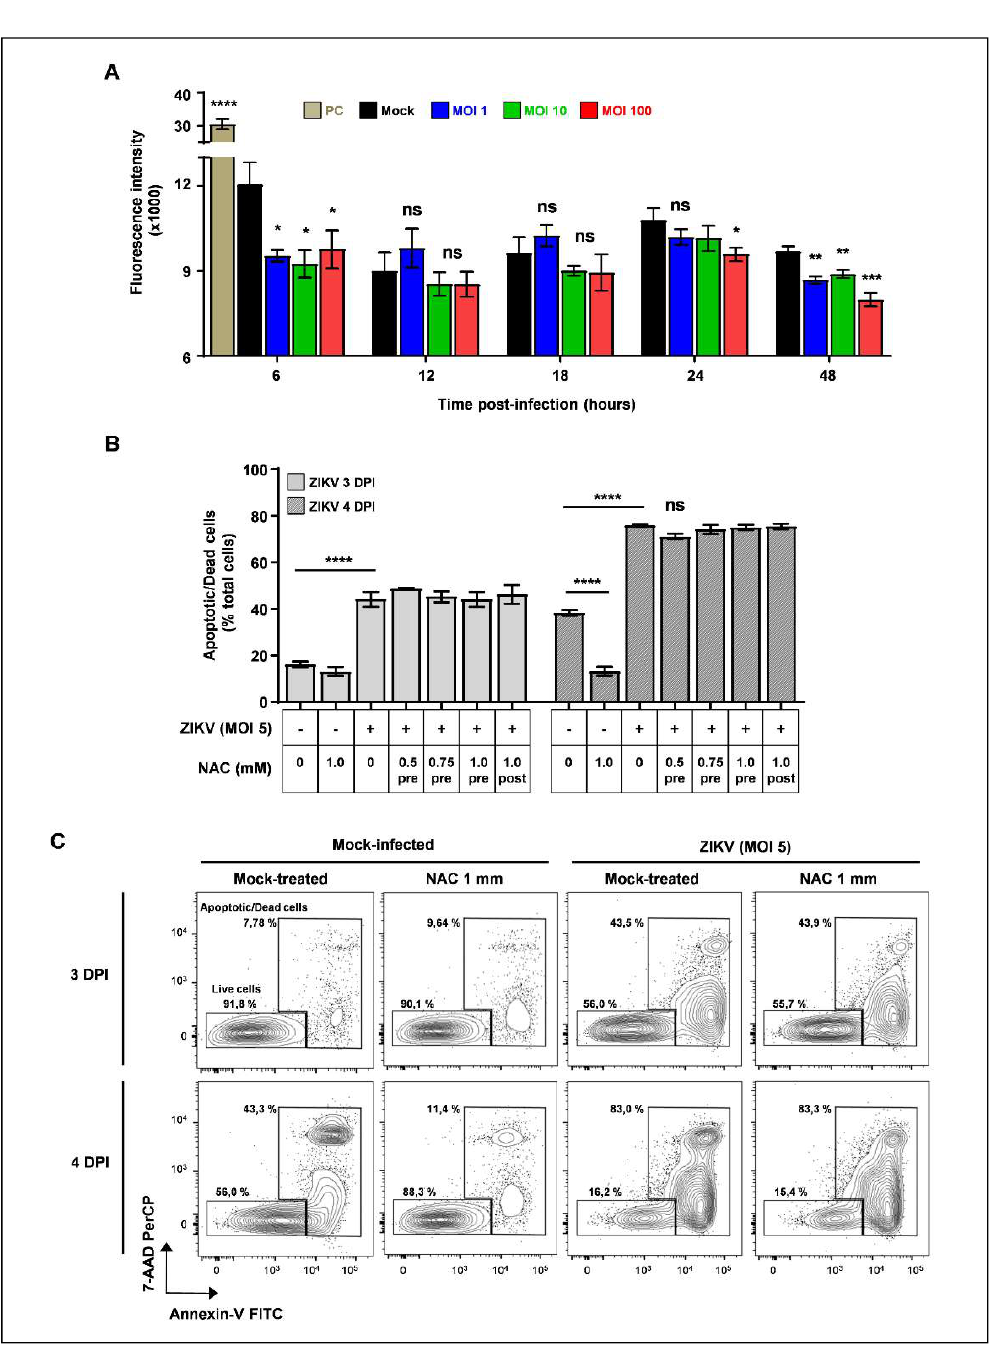
Figure 4. ZIKV-induced cell death is independent of ROS production. ( A ) Mock- or ZIKV-infected (MOI 1, 10, and 100) SH-SY5Y cells were harvested at the indicated timepoints post-infection and stained with DCFDA. PC—positive control (tbHP, tert-butyl hydroperoxide). Values are represented as mean ± S.D. Data representative of one experiment are performed in triplicate. ns—non-significant, * p < 0.05, ** p < 0.01, *** p < 0.0001, according to unpaired t-test compared to mock-infected. **** p < 0.0001, according to one-way ANOVA followed by Tukey’s post-test compared to both mock- and ZIKV-infected samples. ( B , C ) Mock- and ZIKV-infected (MOI 5) SH-SY5Y cells treated with NAC (0.5 mM, 0.75 mM, and 1 mM) were harvested at the indicated timepoints post-infection, stained with Annexin-VI/7-AAD, and analyzed by FCM. ( B ) Frequency of double-positive cells (Annexin-V+/7-AAD+) within total cell population. Data are represented as mean ± SD of one experiment performed in triplicate. Pre—treatment before viral inoculation; post—treatment after viral inoculation. ( C ) Representative dot plots showing frequency of live (double-negative Annexin-V-/7-AAD-) and dead (double-positive Annexin-V+/7-AAD+) cells within mock- or NAC-treated (1 mM) samples stained with annexin-V/7-AAD and analyzed by FCM.